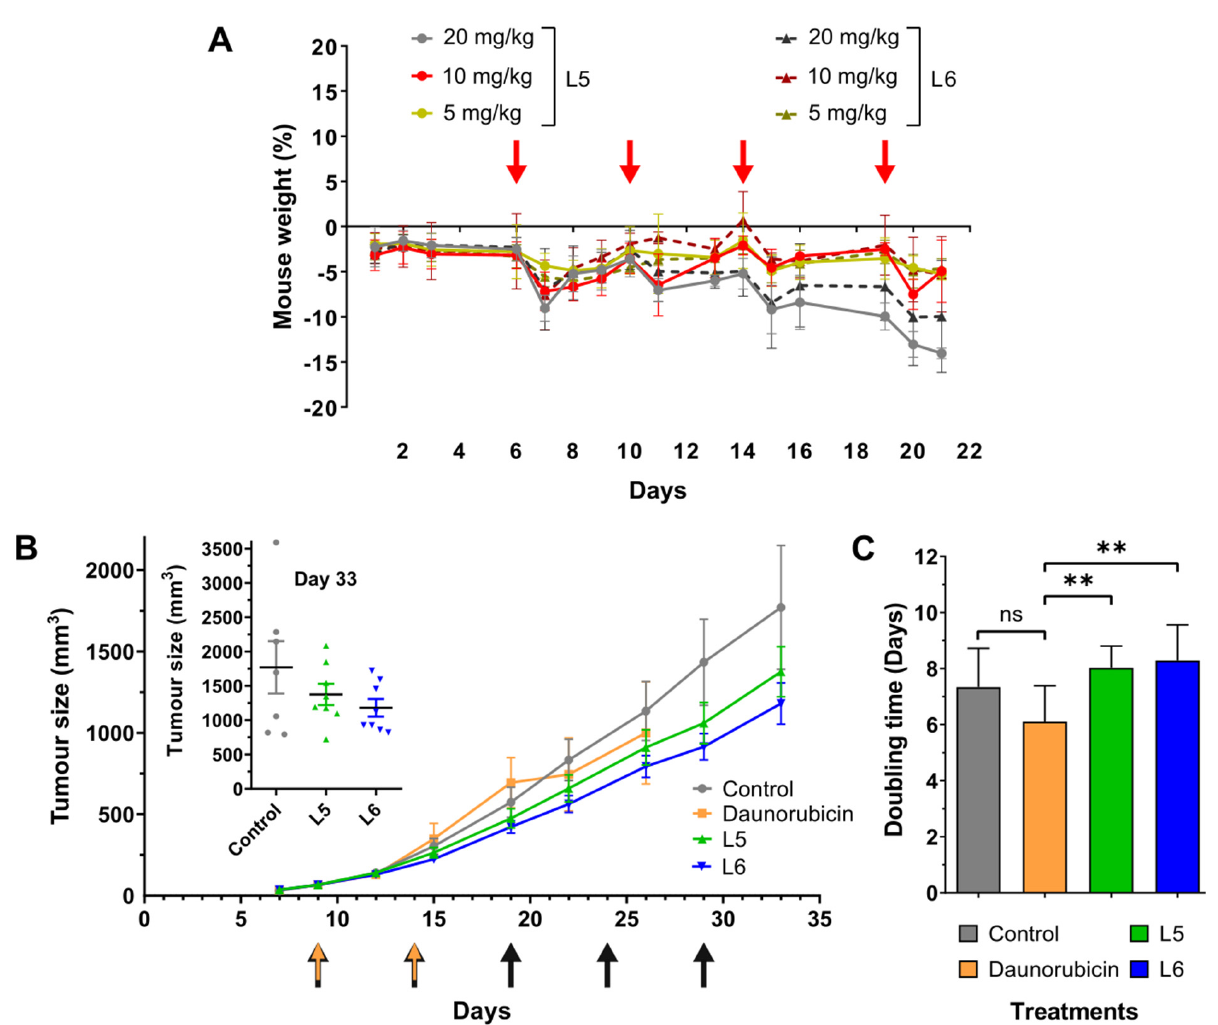
Figure 4. In vivo toxicity and antitumour effect of conjugates L5 and L6 . ( A ) Mouse body weight in chronic toxicity studies (%, mean ± SD, n = 3) after administration of either L5 or L6 , in three different concentrations, calculated on Dau content: 5 mg/kg, 10 mg/kg and 20 mg/kg. Four treatments (red arrows), three mice per group. ( B ) Tumour volume (mm 3 , mean ± SEM, n = 8). Administration regime: 0.9% saline (control group, black arrows), Dau (1 mg/kg, orange arrows) and PDCs (10 mg/kg calculated on Dau content, black arrows), every 5th day starting from day 9. ( C ) Calculated tumour doubling time for control, Dau- and PDC-treated groups (days, mean ± SD, n = 8). ns: non-significant difference. **: significant difference at p < 0.01.